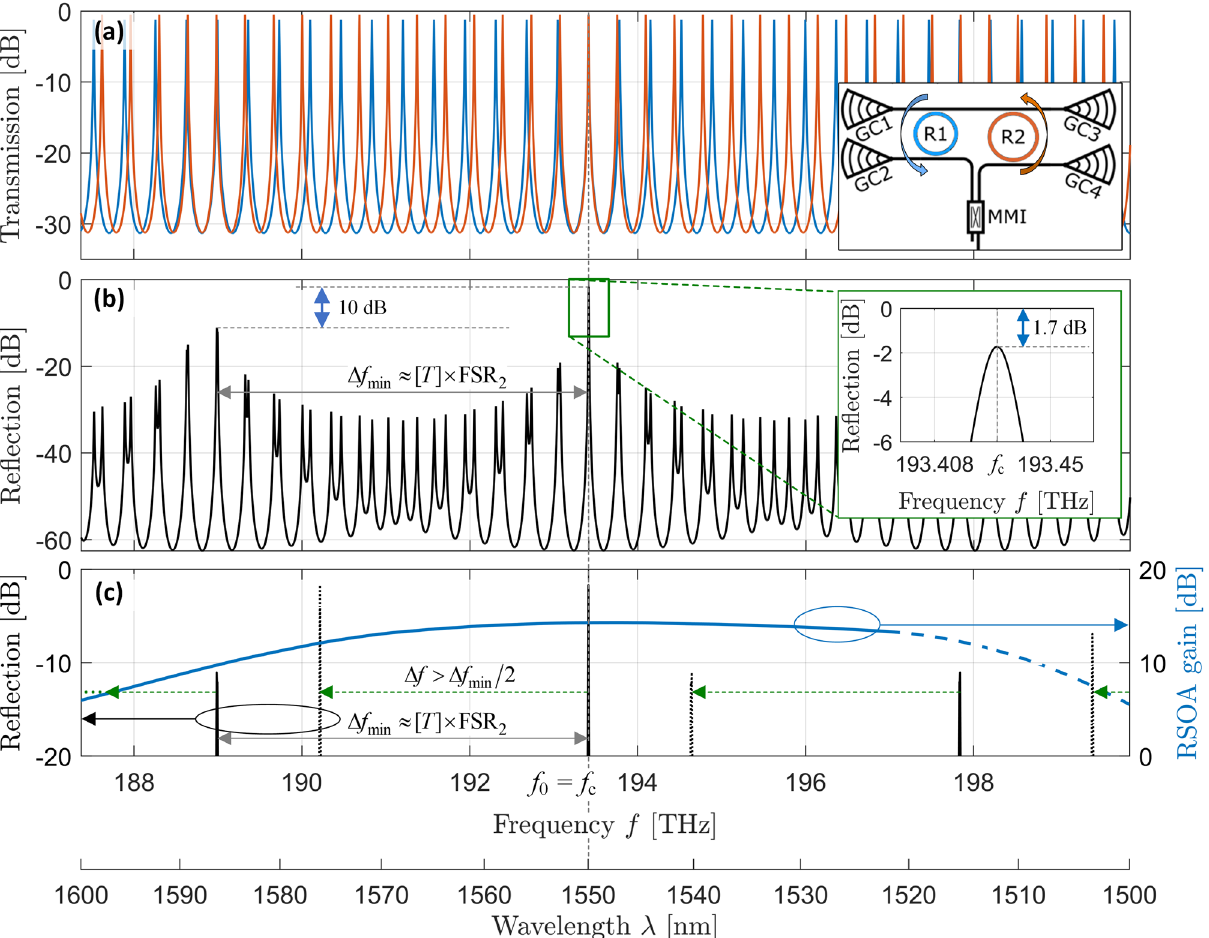
Figure 3. Frequency-dependent reflection characteristics of the external-cavity circuit calculated with the parameters extracted from through-measurement (GC 1 → GC 3), see Supplementary Section 2. ( a ) Drop-port transmission of the individual rings. ( b ) Overall reflection spectrum of the external-cavity circuit. The main peak height indicates a minimum on-chip reflection loss of 1.7 dB, see Inset. ( c ) Exemplary gain spectrum of the RSOA according to Fig. 2b for an injection current of I = 20 mA (blue line) with schematic resonance peaks (black lines) as in ( b ). The blue solid line corresponds to measured values of the RSOA gain, whereas the blue dashed line is an estimated extrapolation towards higher frequencies. The solid black lines indicate the strong main reflection peak at the target frequency f 0 , which, for the depicted case, corresponds to the center frequency ( f c = 193.2 THz; λ c = 1550 nm) of the gain spectrum, along with the most prominent side peaks that are most prone to unwanted lasing. The dotted black lines indicate the corresponding peaks after a detuning by � f > � f min / 2 where (cid:31) f min ≈ [ T ] × FSR 2 , indicated by green